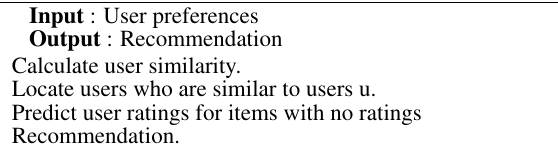
Algorithm 1 User-based collaborative filtering algorithm.